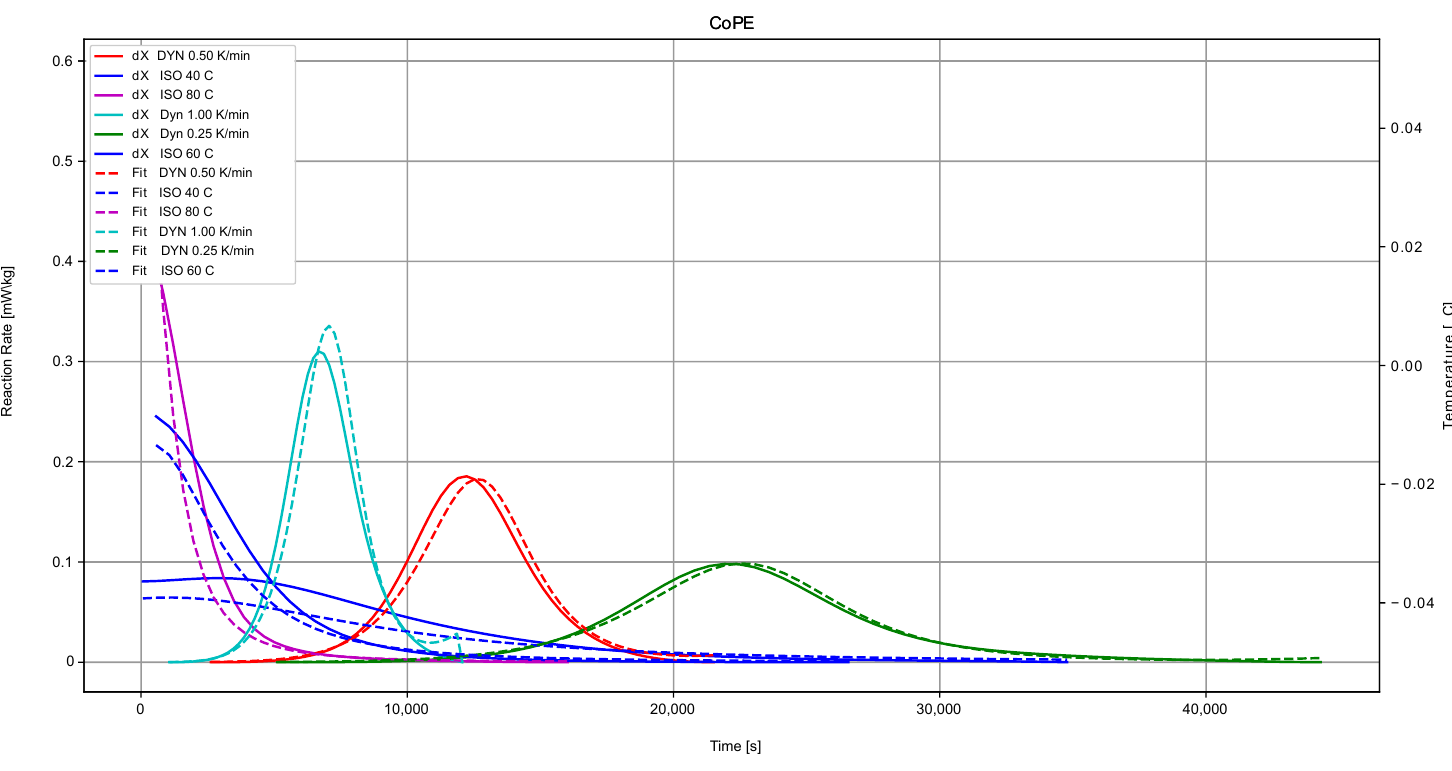
Figure A1. Comparison between measured reaction rate during DSC measurements and the prediction of the model fitted with CoPE